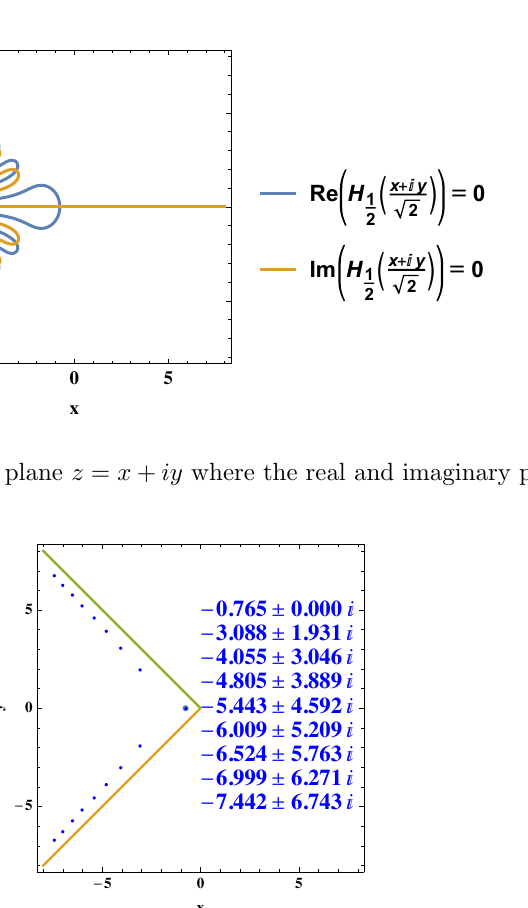
(cid:16) (cid:17) z p with the largest real part. 2 2